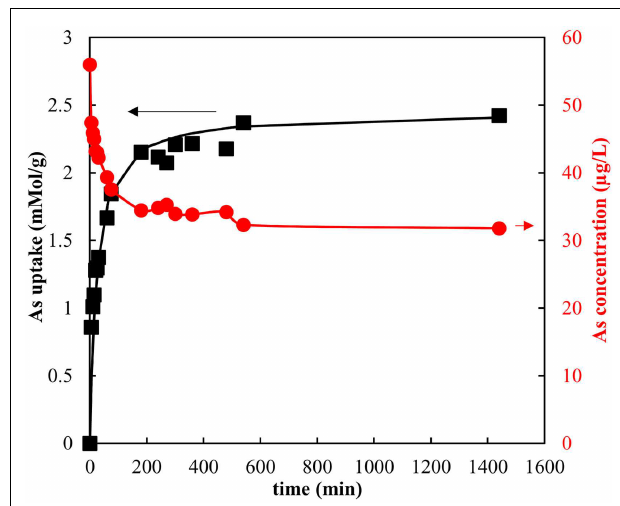
FIGURE 3 |As uptake on GAC (squares) and remainingAs concentration (circles) as functions of time in absence of potential (Carbon dosage: 10g/L, absence of potential)